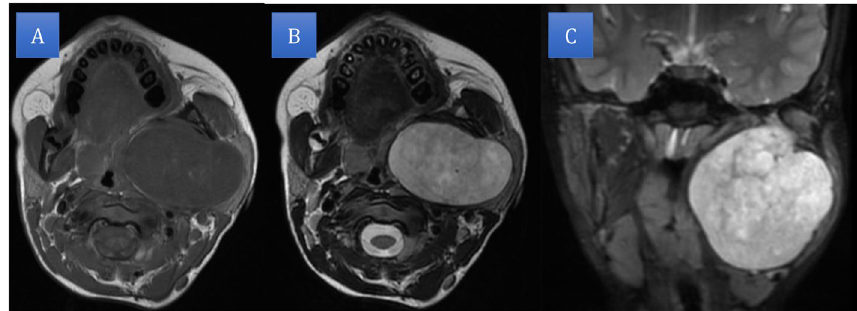
Fig. 3 Contrast-enhanced MRI showing the tumor to be well defined, T1 isointense A and T2 hyperintense B , C